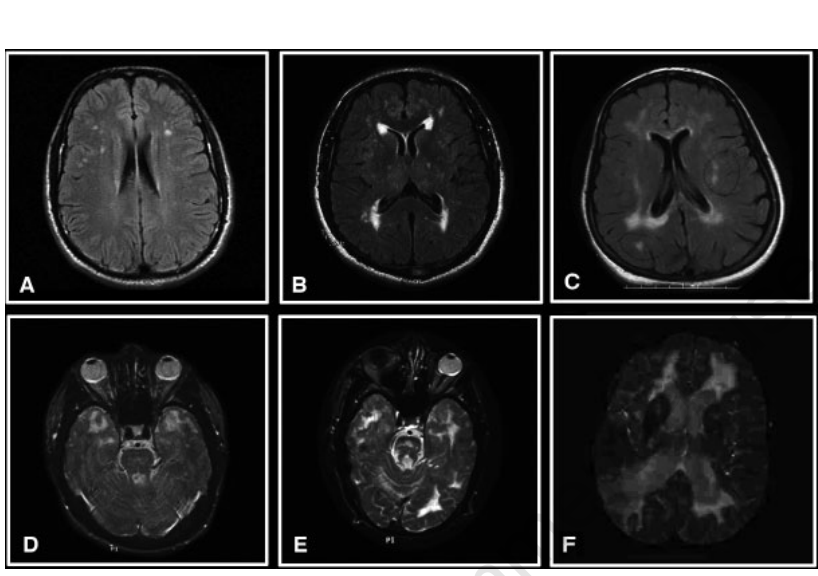
Figure 2. Representative magnetic resonance imaging scans from family members. (A) From sister (III: 32 in Figure 1). Note multiple lacunar lesions in deep white matter. (B) (Index case III-37). Note multiple periventricular ischemic lesions C & D (from patient III-38). Scans (E & F) (From mother II-52) showing different ischemic lesions in brain and brain